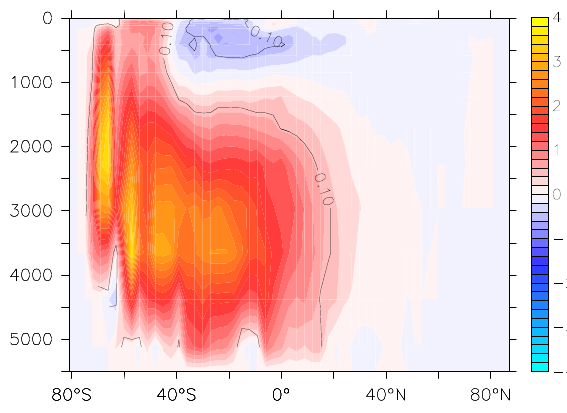
Fig. 18. The regression coefficient of the Antarctic sea ice volume with the strength of the global meridional overturning circulation. The regression coefficient is given in 10 − 12 Sv m − 3 . The contour indicates the area where the regression coefficient is statistically sig- nificant.